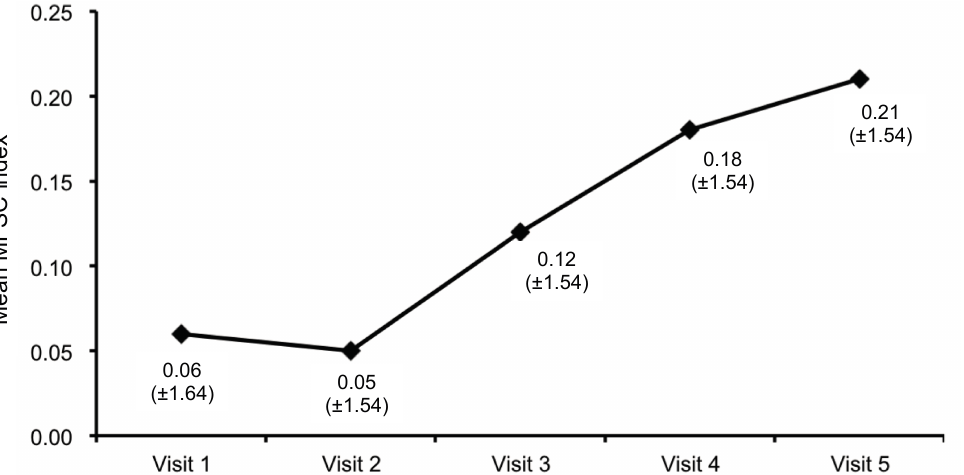
Figure 5. Course of mean Multiple Sclerosis Functional Composite (MSFC) index (±SD) during the prospective observational period on treatment with IM IFNb-1a (patients with documentation of the MSFC at all visits, n =